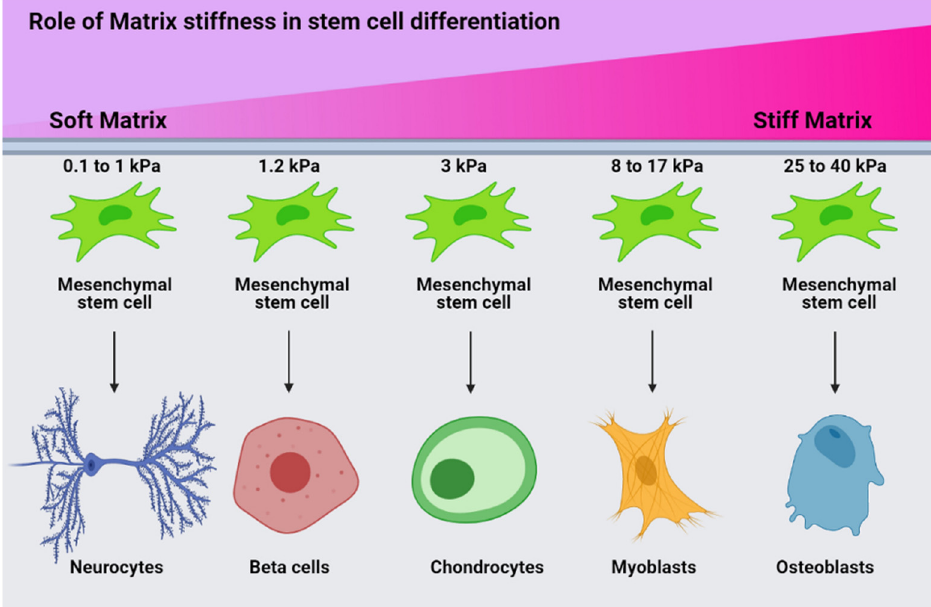
Figure 8. Schematic representation of the relationship between matrix stiffness and HMSC differentiation. Matrix stiffness significantly affects the differentiation of HMSCs; higher stiffness leads to osteogenic differentiation.